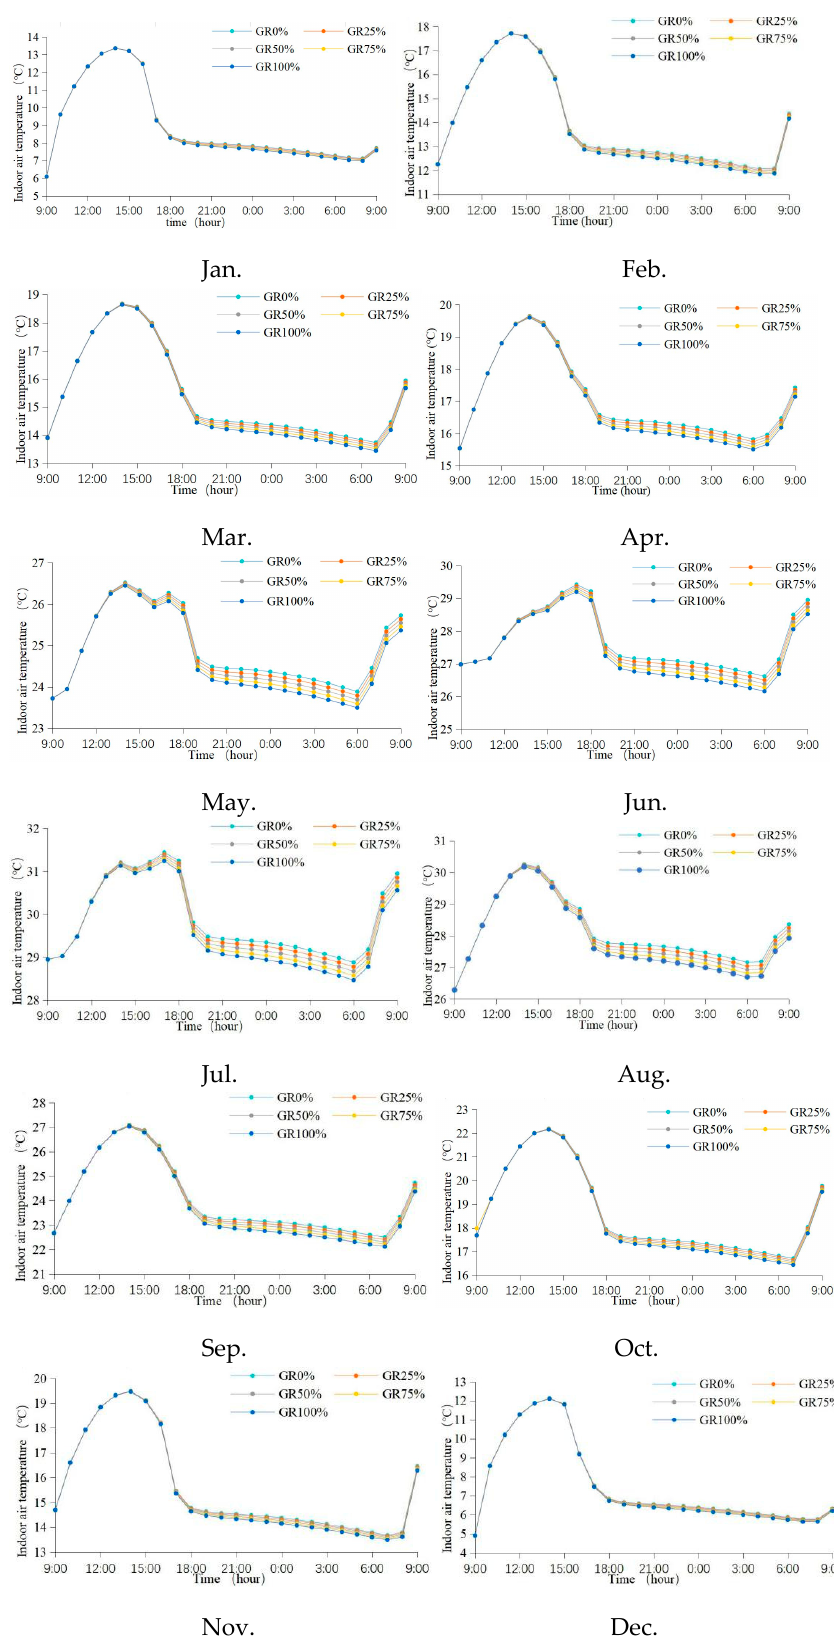
Figure 4. Effects of green roof rates on indoor air temperature over the 12 months.